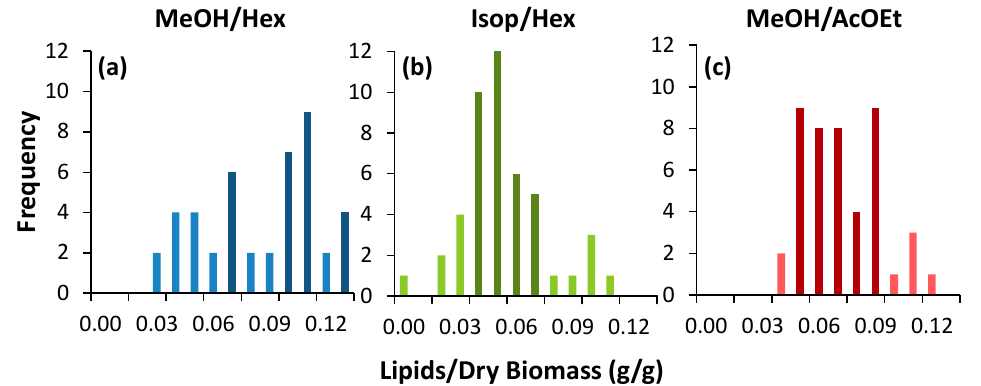
Figure 1. Histogram plots of frequency from lipid yield (Lipids/Dry Biomass, L/DB, g/g) results for the three simulations, namely ( a ) methanol/hexane (MeOH/Hex); ( b ) isopropanol/hexane (Isop/Hex); and ( c ) methanol/ethyl-acetate (MeOH/AcOEt) of design of experiments (DoE). The obtained results from the FCC, testing the MeOH/Hex type, are included in Table 3. Experiments were performed in a randomized order. The corresponding FCC design matrices for Isop/Hex, MeOH/AcOEt, and their observed responses are presented in the supplementary material (Tables S1 and S2). Table 3. Face-Centered Composite (FCC) design matrix for MeOH/Hex and observed